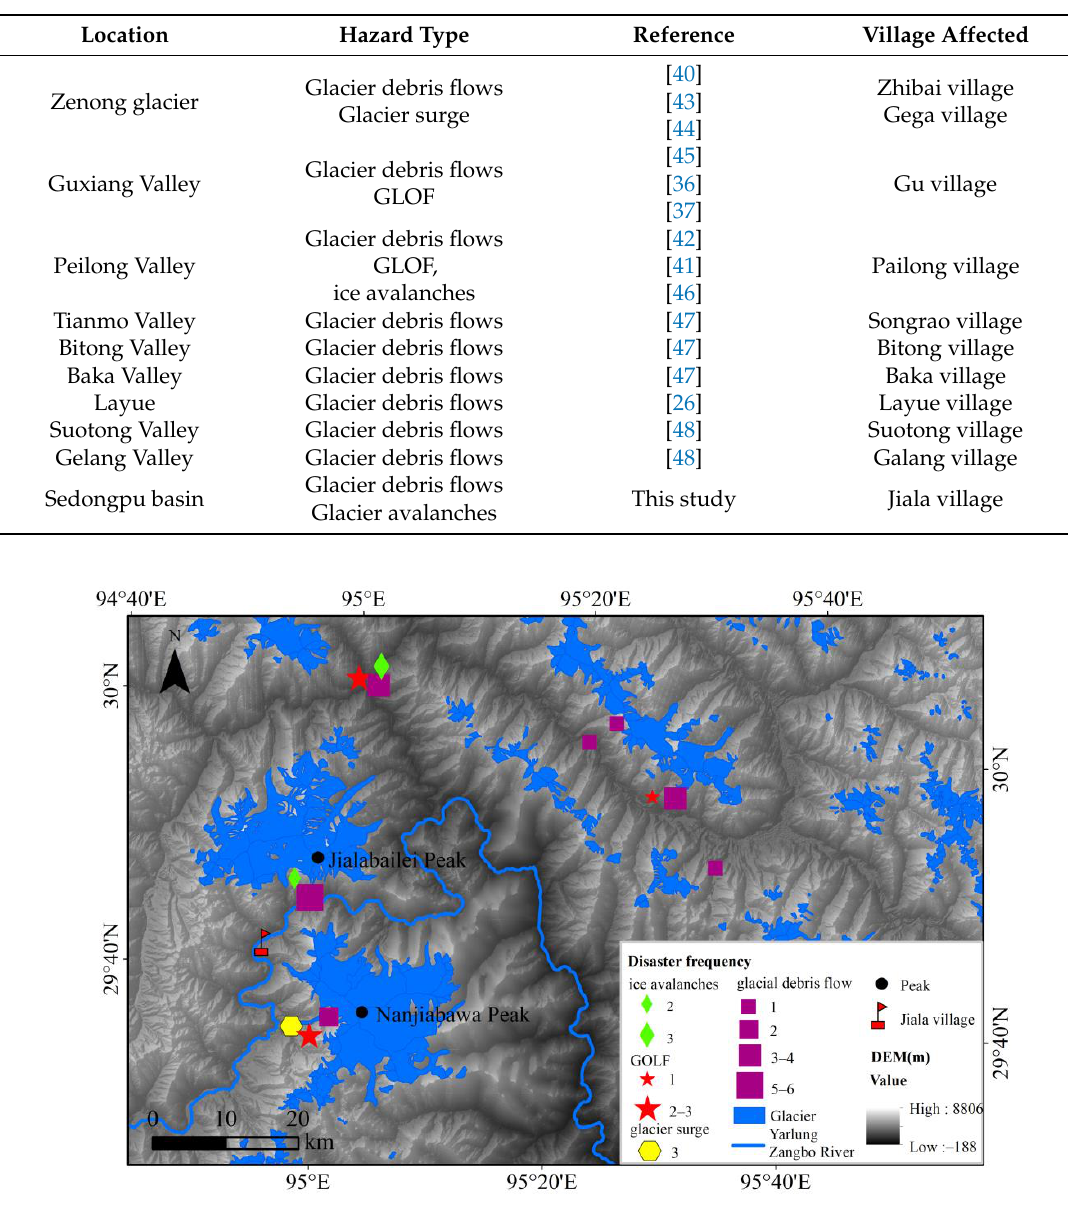
Table 3. Historical glacier hazard events in the Sedongpu basin.